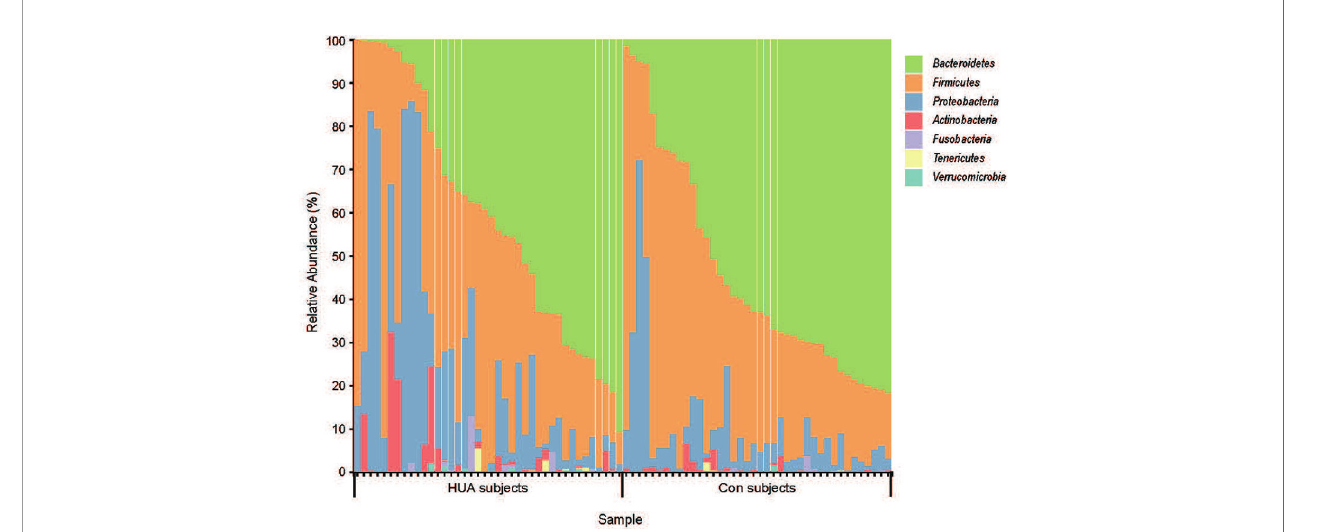
FIGURE 1 | The taxa-bar of gut microbiota in HUA and Con subjects at the phylum level. HUA, hyperuricemia; Con,